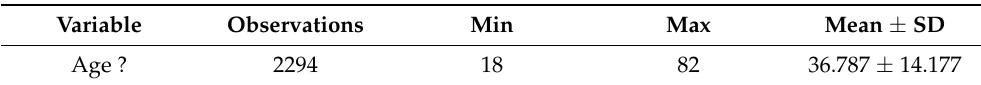
Table 2. Age of the respondents.